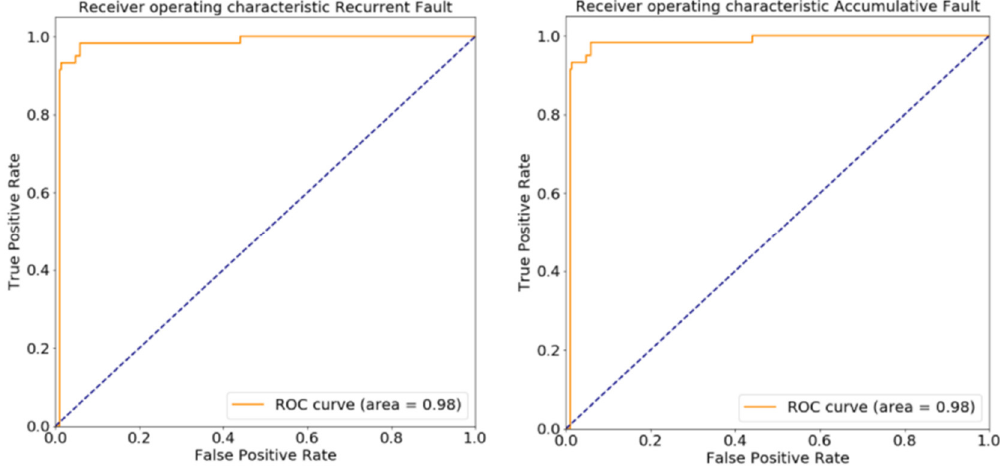
Figure 12. ROC Curve of LSTM Model.